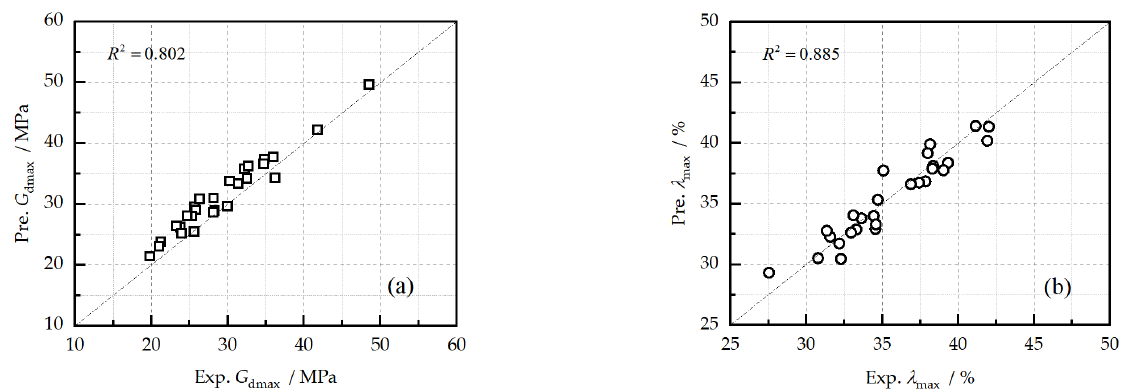
Figure 15. Prediction results (Pre.) against experimental results (Exp.): ( a ) maximum dynamic shear modulus, ( b ) maximum damping ratio.